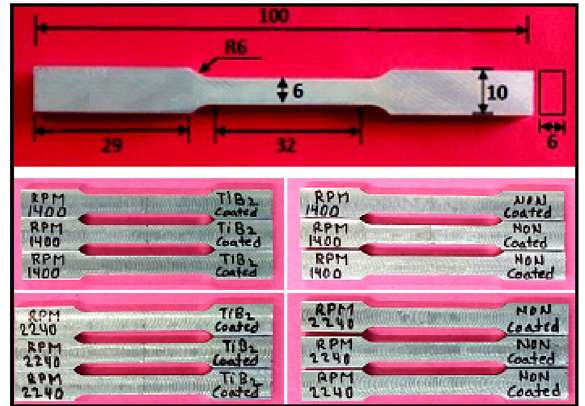
Figure 5. Tensile testing samples and dimension.